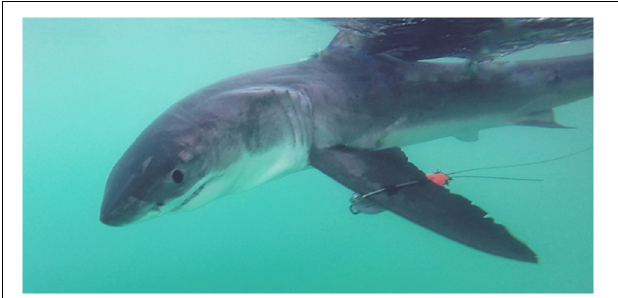
FIGURE 2 | Deployment of a CATS cam tag on the pectoral fin of a juvenile white shark (2.15 m fork length), mimicking the attachment of a remora fish